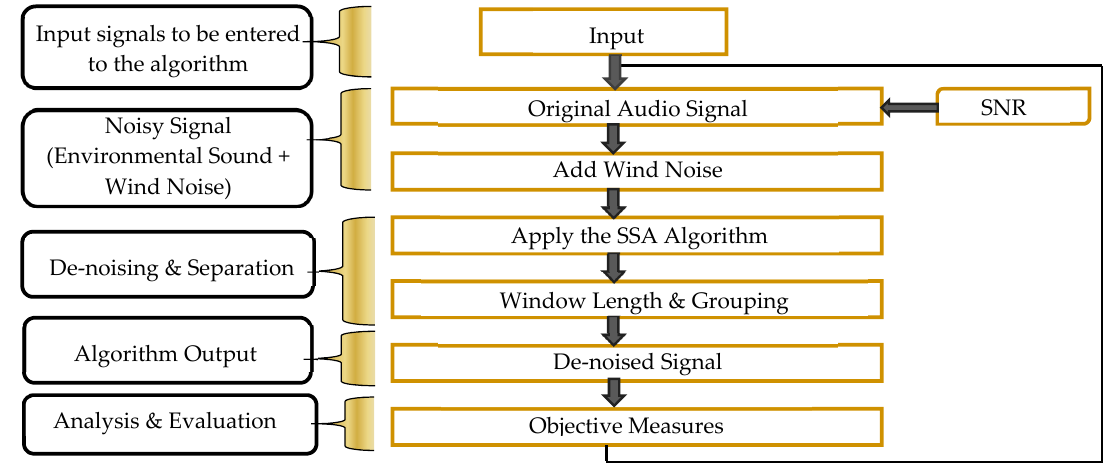
Figure 5. A flow chart of the experimental procedure.